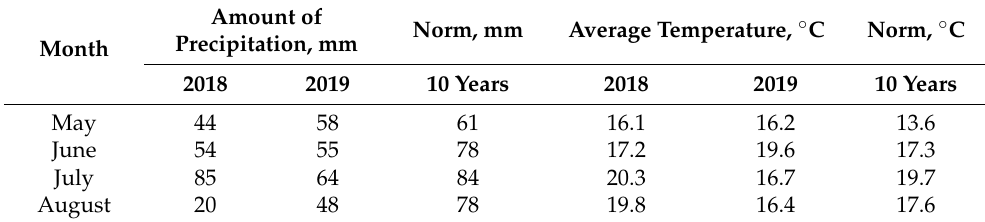
Table 2. The weather conditions in Moscow during field